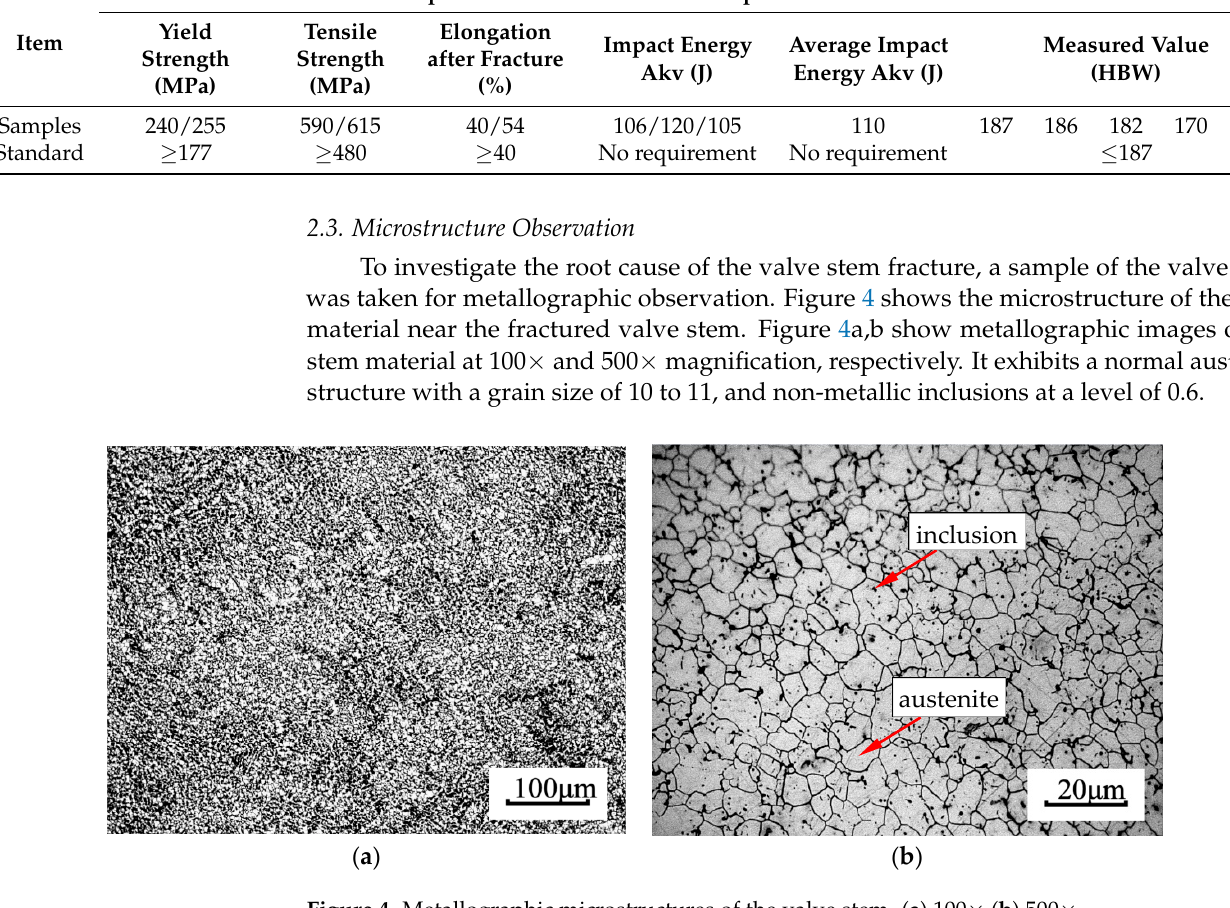
Figure 4. Metallographic microstructures of the valve stem. ( a ) 100× ( b ) 500×.